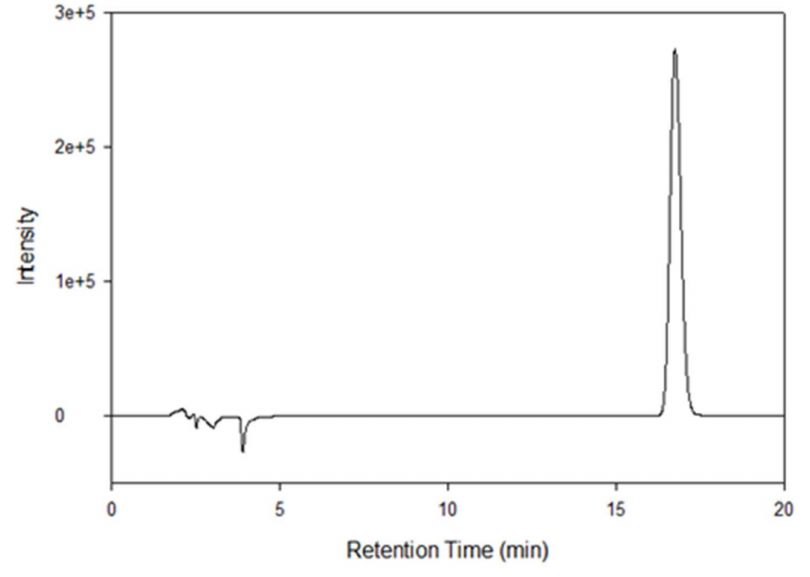
Figure 2. HPLC chromatogram of resatorvid. Format like 1e+5 means 1 × 10 5